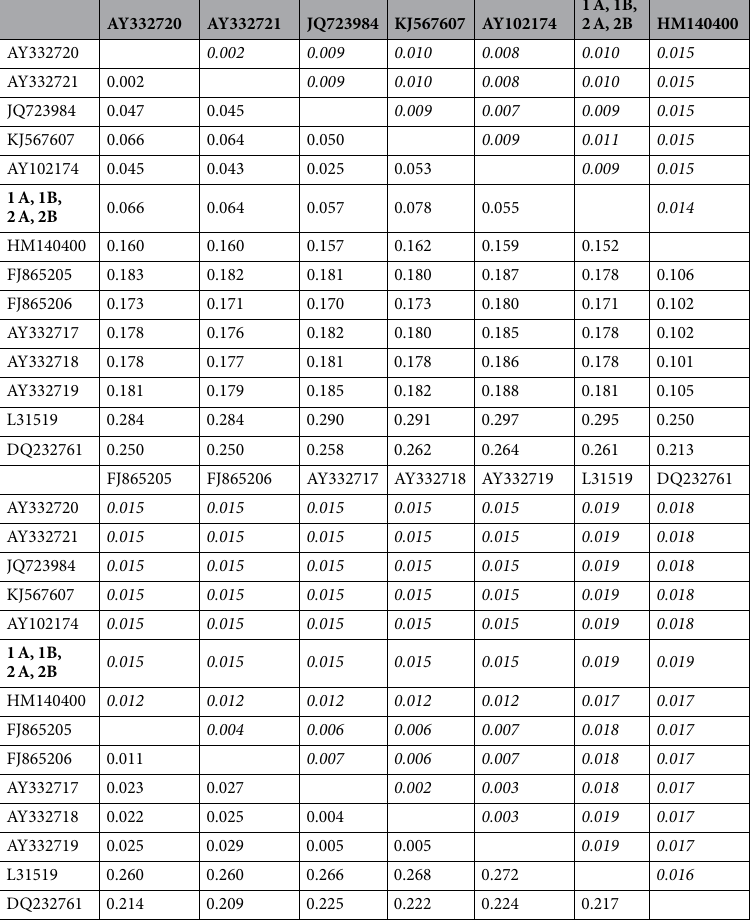
Table 2. Values of uncorrected p -distance calculated for sequence pairs. The values of standard error are given in italics. Sequences of Loxodes magnus and Orthodonella apohamatus (accession numbers: L31519 and DQ232761, respectively) were used as outgroups. The sequences that were determined in the present study are marked in bold.